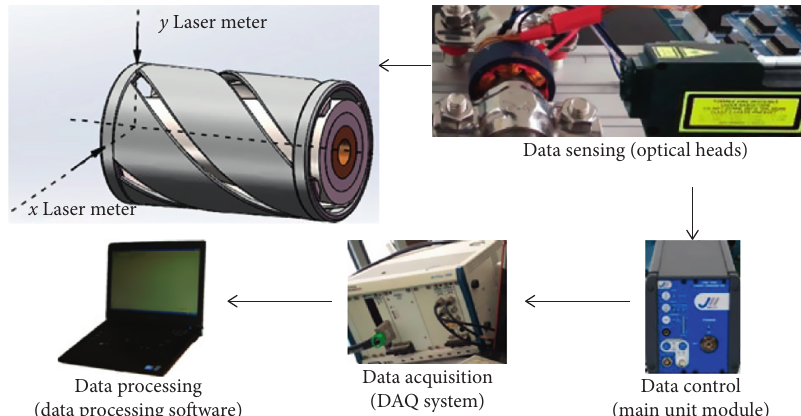
Figure 18: Experimental setup for measuring the radial displacement of the